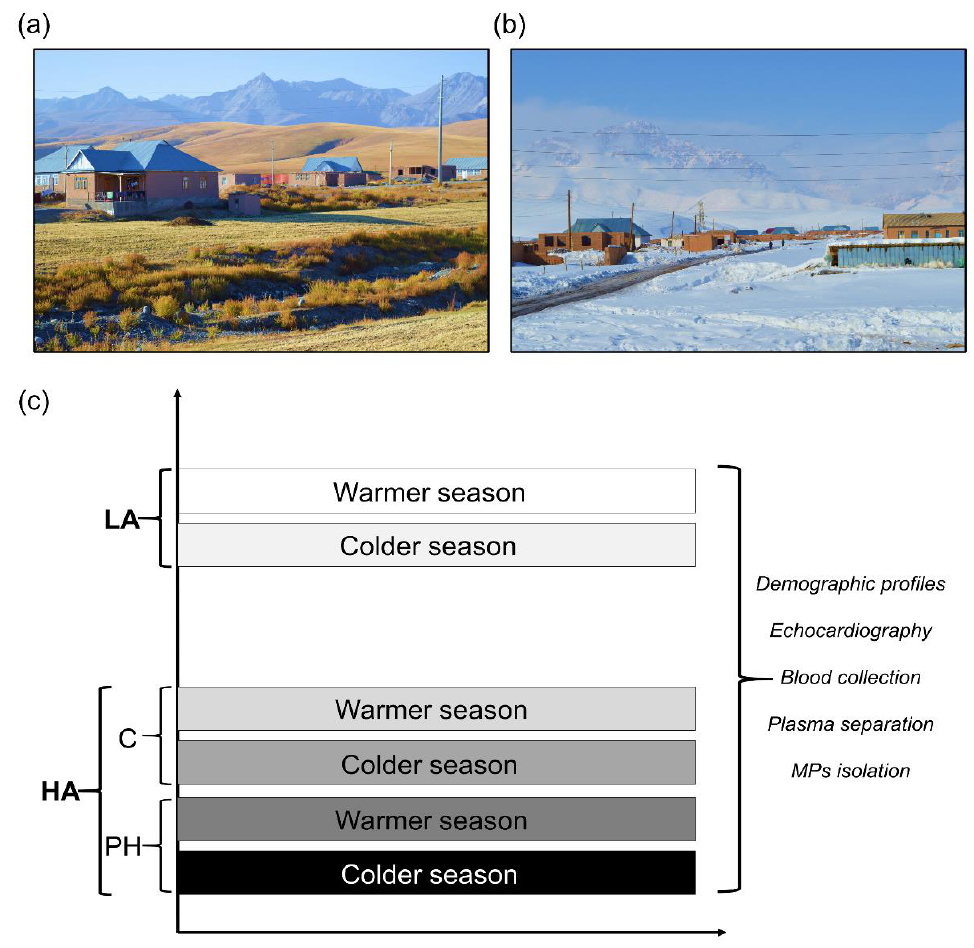
Figure 1. High altitude location in Kyrgyzstan and experimental design. The photographs from high altitude village Sary-Mogol (approx. 3000 m) during the late summer ( a ) warmer season and late winter ( b ) colder season are presented. The photographs may have been previously posted on different social media and used for the documentary film. The experimental design is depicted ( c ).